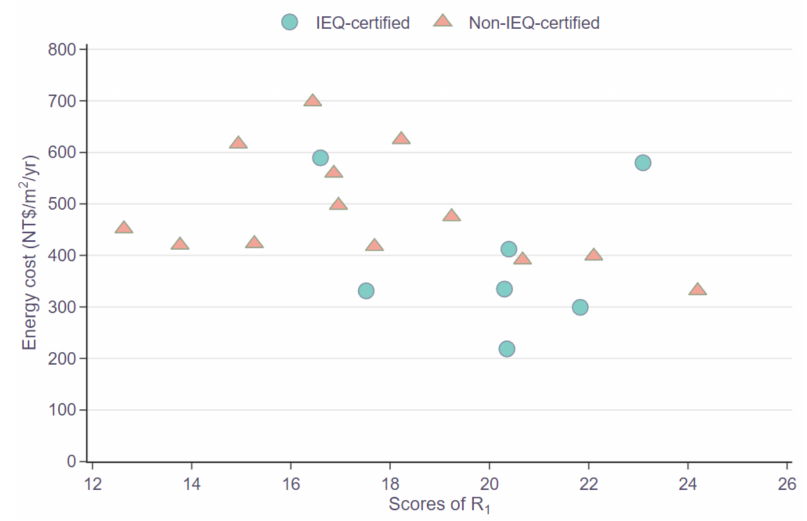
Figure 3. R 1 scores and C E performances of the investigated